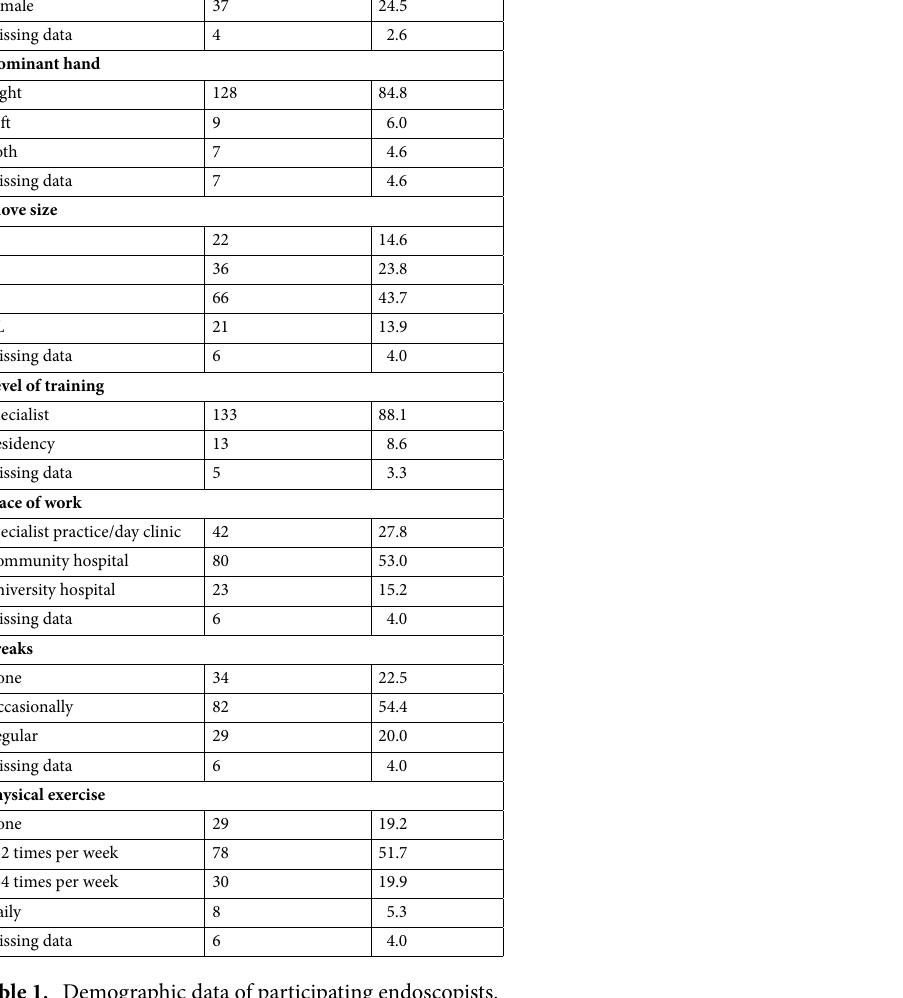
Table 1. Demographic data of participating